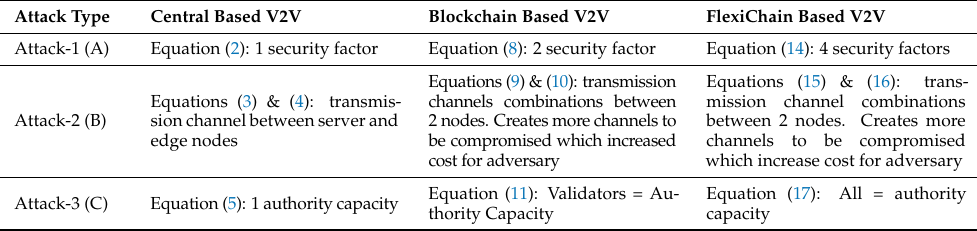
Table 6. Comparison Between Central Versus Blockchain Versus